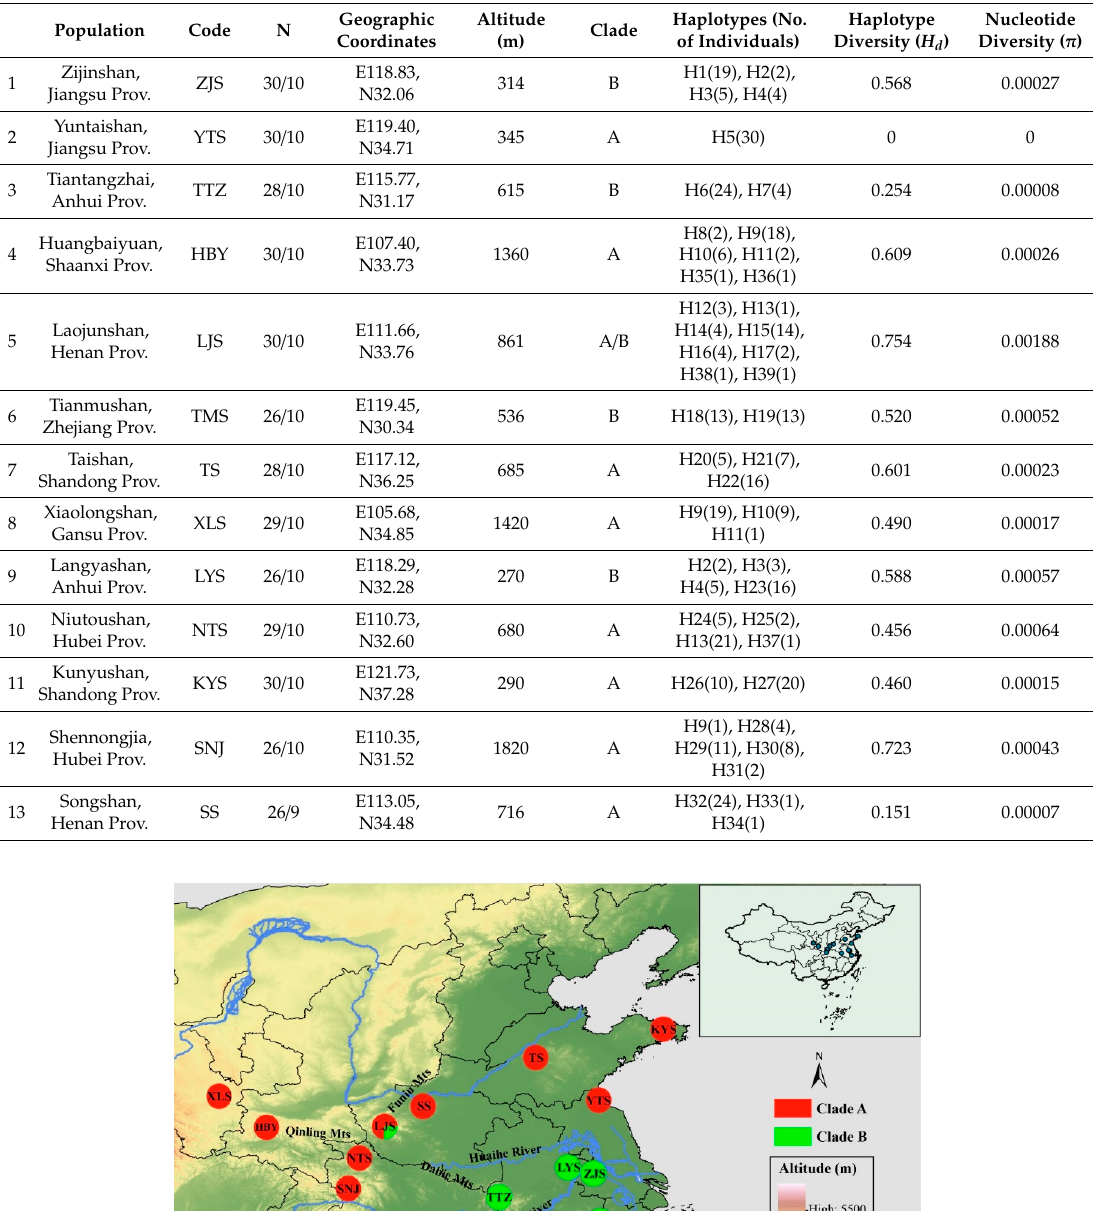
Table 1. P. glacialis population genetic parameters and sample data. (N, Sample size subjected to mtDNA / SNP examination; “H”, for mtDNA haplotype; Clade A / B as shown in Figure 3).